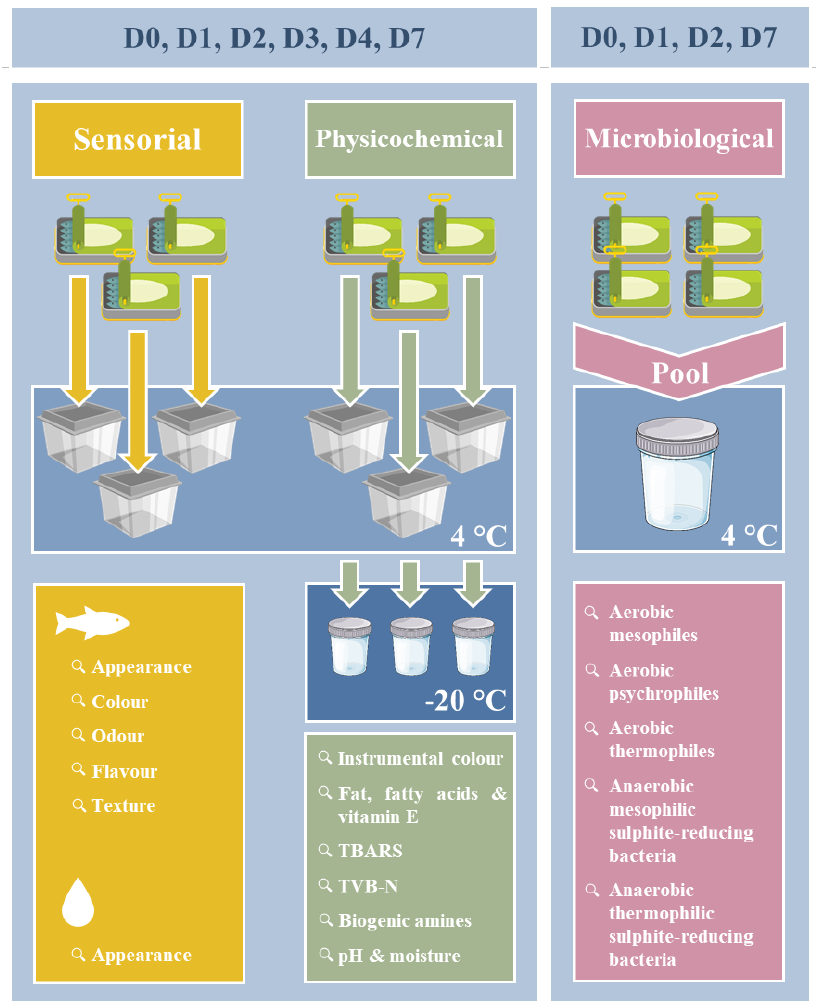
Figure 1. Experimental design of the evaluation of the overall quality of each canned sardine product, from the same batch, during refrigerated storage (D, day).